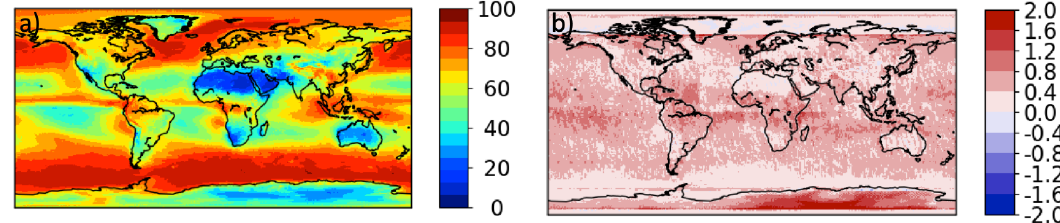
Figure 5. Multi-year (2014–2018) mean daytime cloud fraction from S-NPP VIIRS retrieval ( a ), and cloud fraction difference between retrievals using all footprints and only using footprints with VZA < 66 ◦ ( b